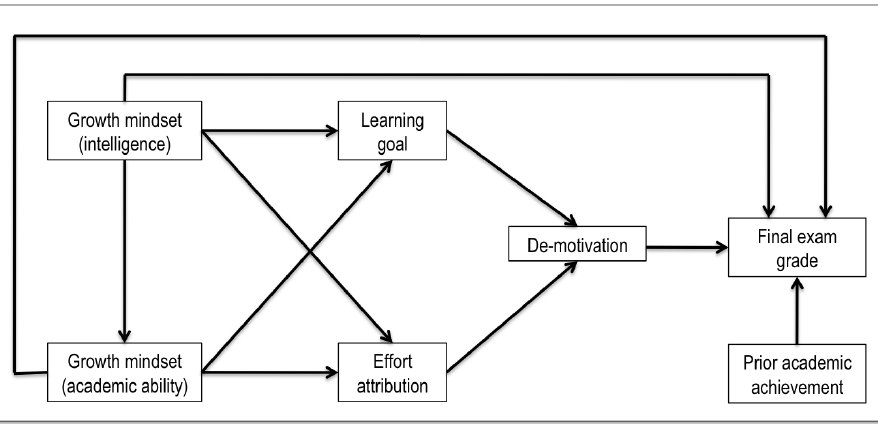
Figure 1. Conceptual model of the relationships between mindset, motivational factors, and academic